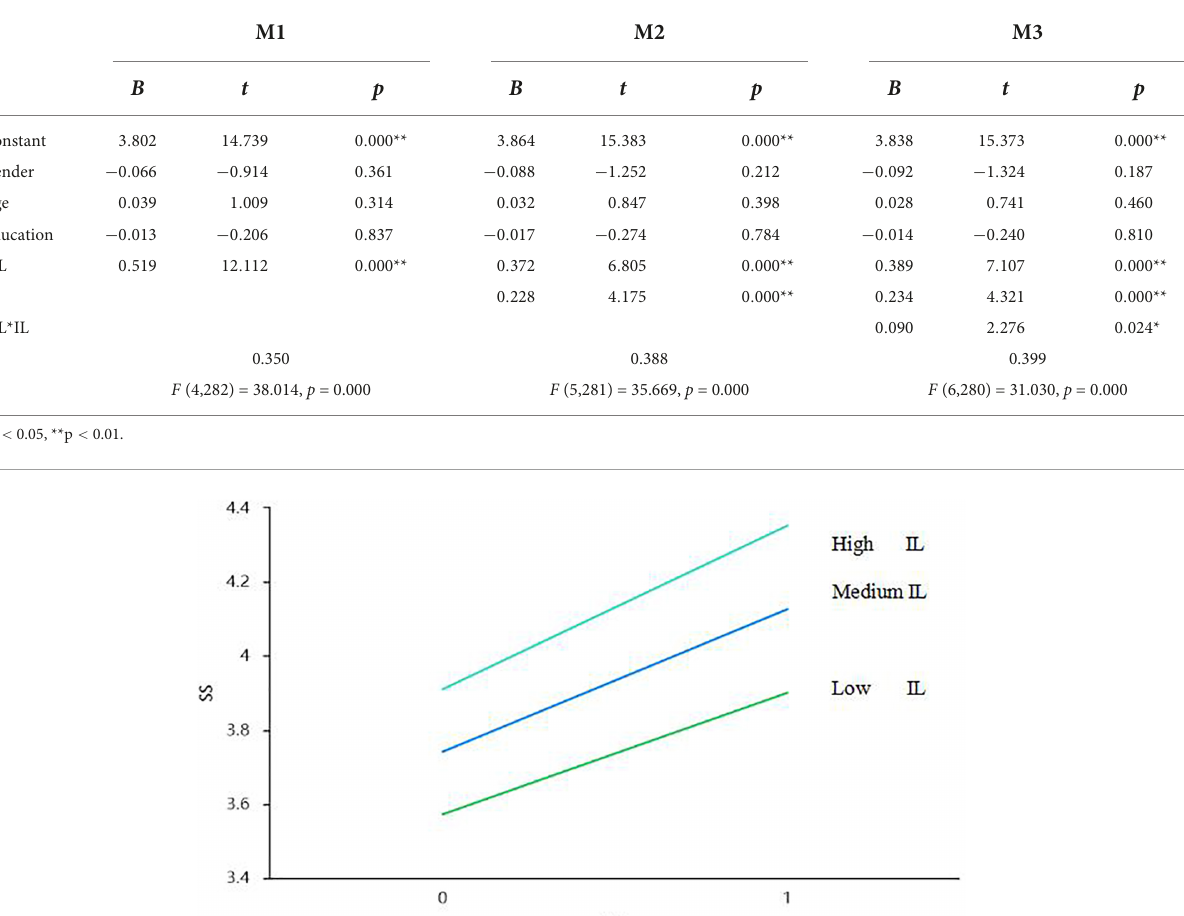
TABLE 10 Moderating effects of identification with leaders.